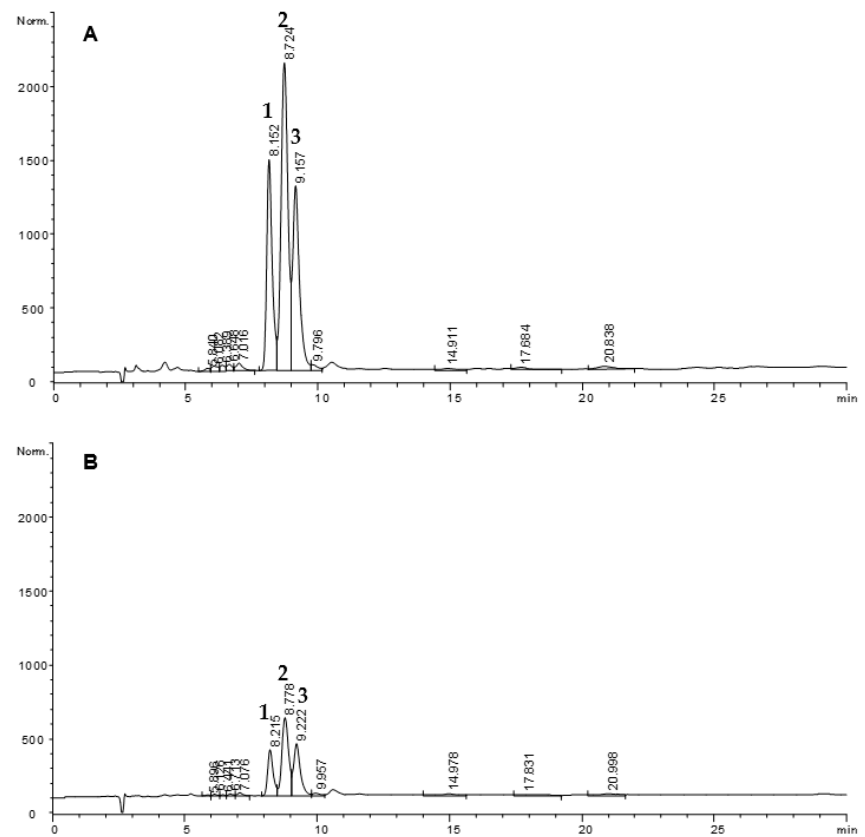
Figure 3. HPLC ‐ UV (232 nm) chromatograms of methyl linoleate hydroperoxides ( 1 ‐ 3 ) before ( A ) and after simulated gastric digestion ( B ). Chromatographic conditions: LiChrospher Si 60, 5 μ m column; heptane:diethylether (88:12). Peak assignation: 1 , methyl 13 ‐ hydroperoxy ‐ (Z) ‐ 9,(E) ‐ 11 ‐ octadecadienoate; 2 , methyl 13 ‐ hydroperoxy ‐ (E) ‐ 9,(E) ‐ 11 ‐ octadecadienoate and methyl 9 ‐ hydroperoxy ‐ (E) ‐ 10,(Z) ‐ 12 ‐ octadecadienoate; 3 , methyl 9 ‐ hydroperoxy ‐ (E) ‐ 10,(E) ‐ 12 ‐ octadecadienoate [41].